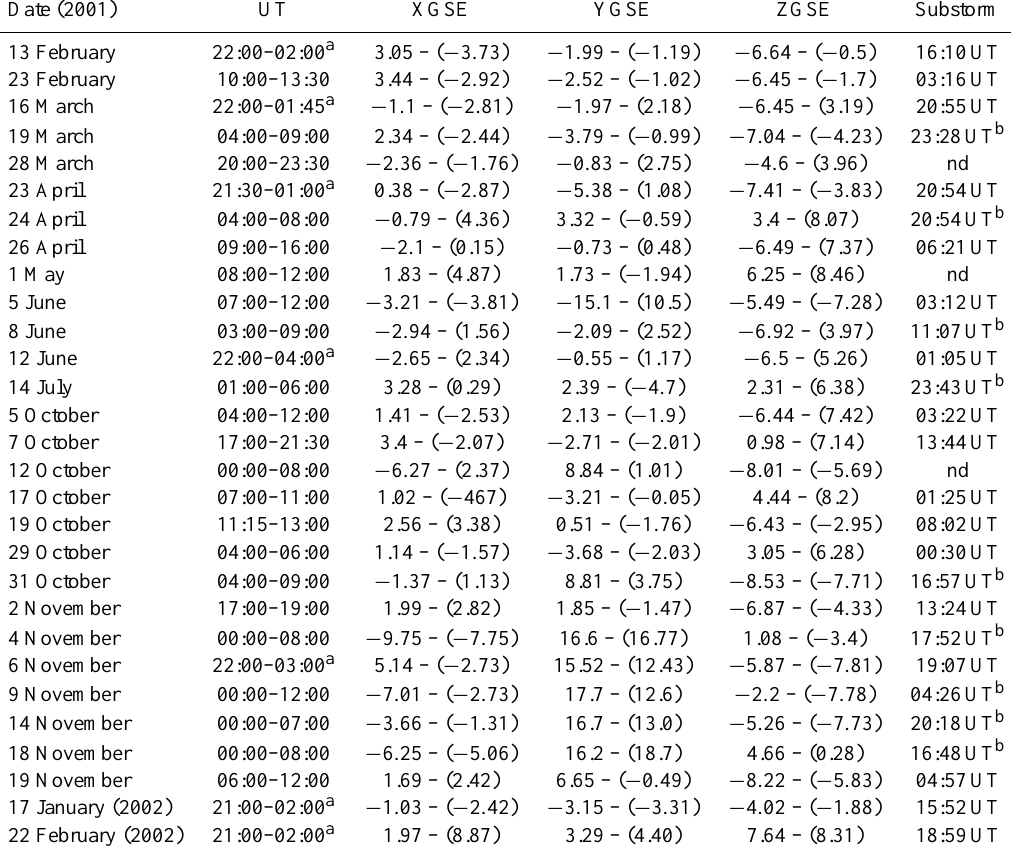
Table 1. Observation